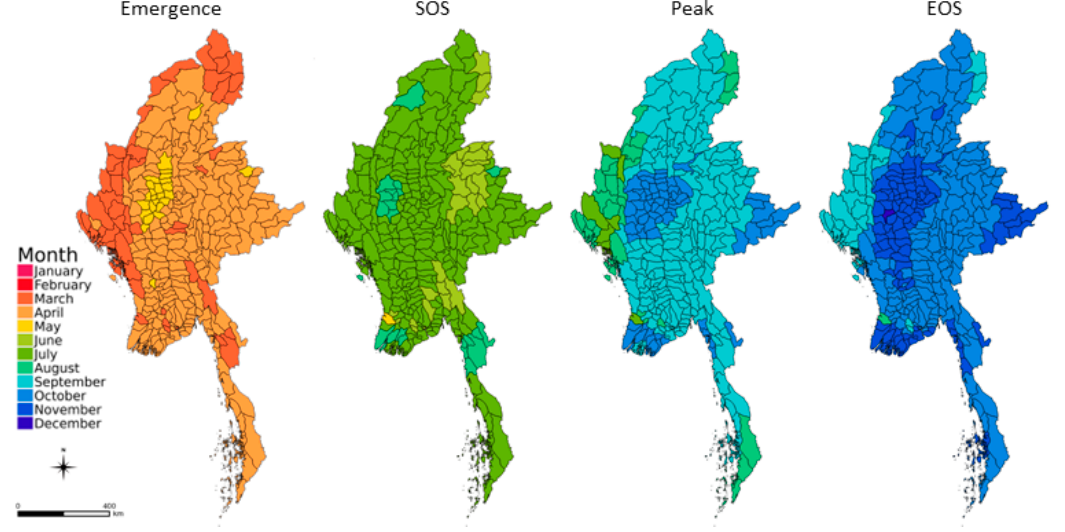
Figure 14. Rice crop calendar during the main wet season crop detected from Sentinel-1 showing mean A. Emergence, B. Start-of-season (SOS), C. Peak, and D. End-of-season (EOS) scaled to administrative units for Myanmar.